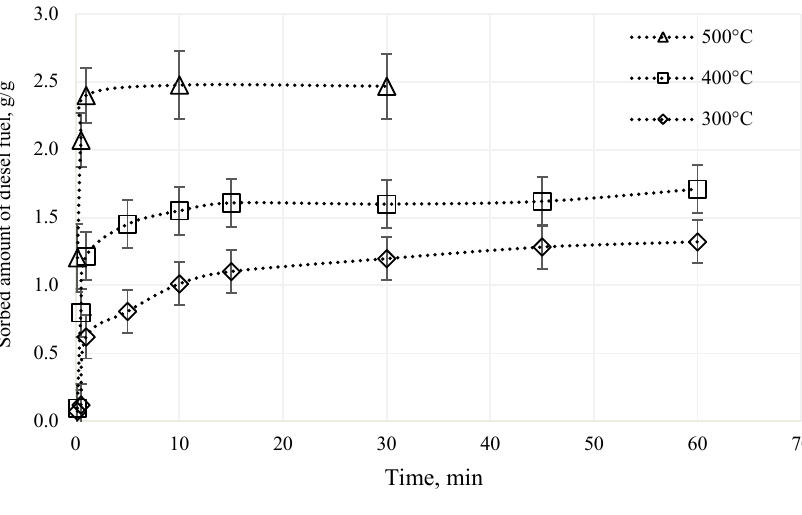
Fig. 7. Sorption kinetics of diesel fuel, sorbent dose 0.1